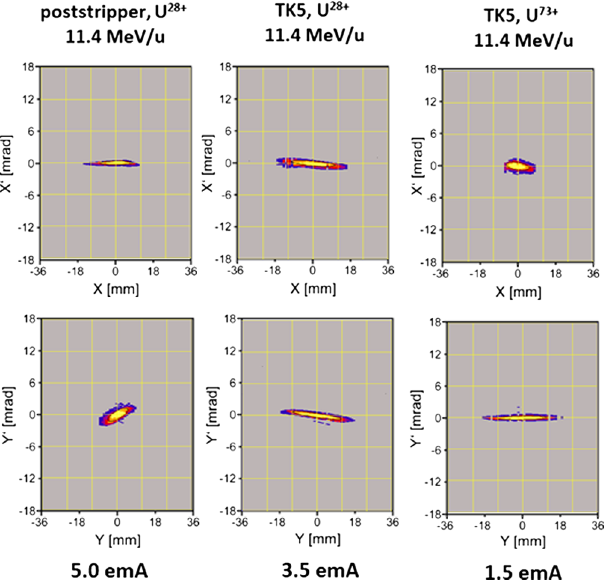
FIG. 5. Beam emittance measurements behind carbon foil stripping and charge separation of high-intensity U beam at 11 . 4 MeV = u in the transfer line to SIS18.